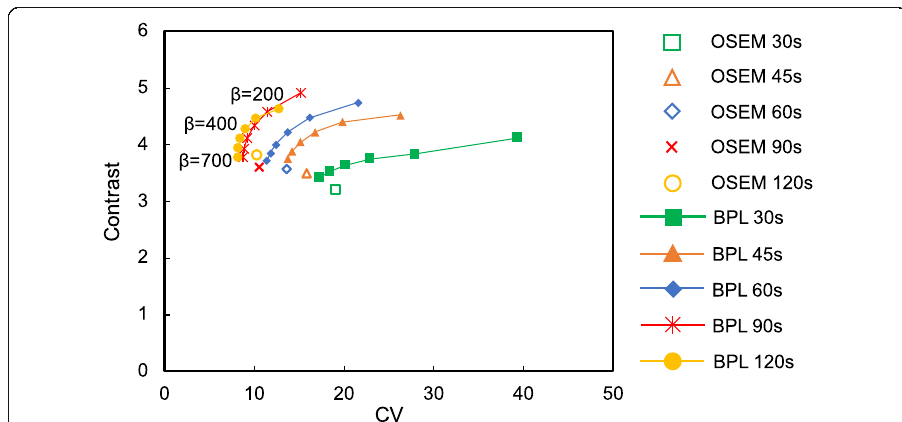
Fig. 4 Relationship between contrast and CV curves of hot spheres with 10-mm diameter using OSEM and BPL reconstructions after each acquisition duration. Plots of OSEM correspond to 2 iterations. Curves for BPL run from left to right with decreasing β values, respectively. Unfilled and filled symbols represent OSEM and BPL,